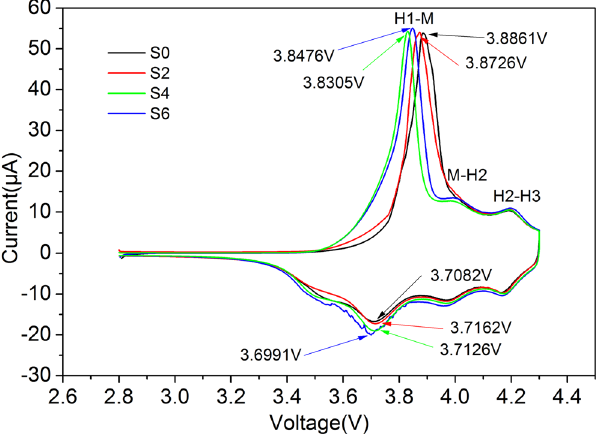
Figure 6. Cyclic voltammograms obtained with scan rate of 0.1 mv·s − 1 for all